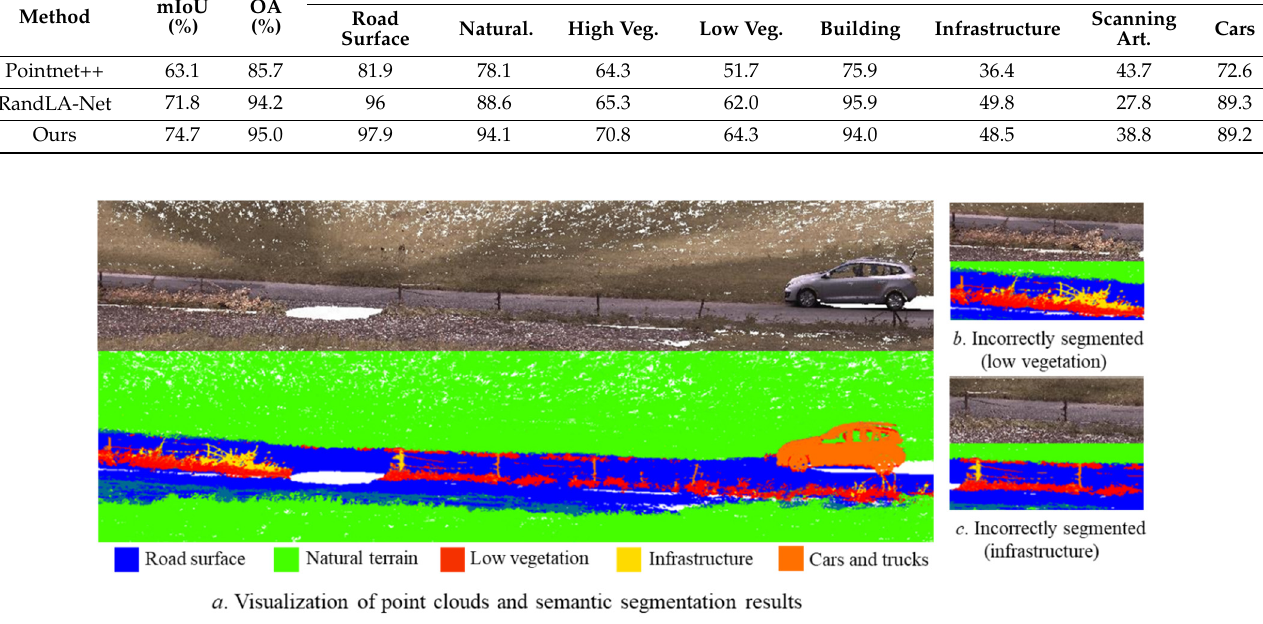
Figure 6. Comparison between colored point clouds and predicted segmentation results (Semantic3D).